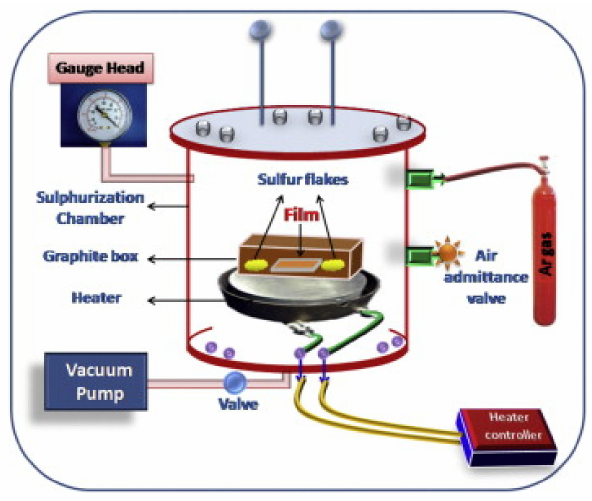
Figure 1. Experimental setup of the sulfurization (reprinted with permission from [3]; Copyright© 2015 Elsevier